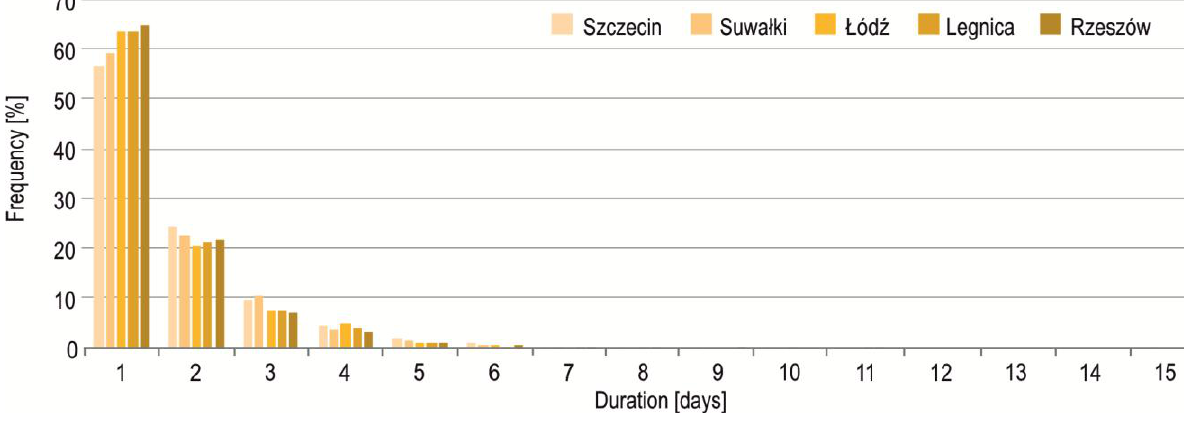
Fig. 7. Number of sequences of days with atmospheric fronts at selected stations in the period 2006-2015